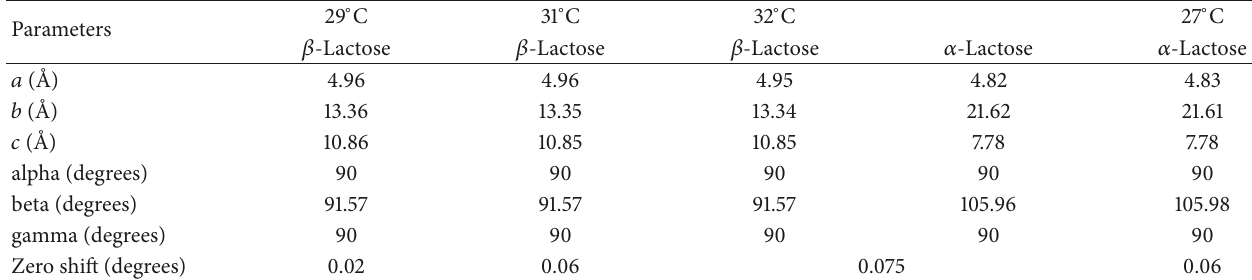
Table 3: Cell parameters and zero shift calculated from the Rietveld refinement.